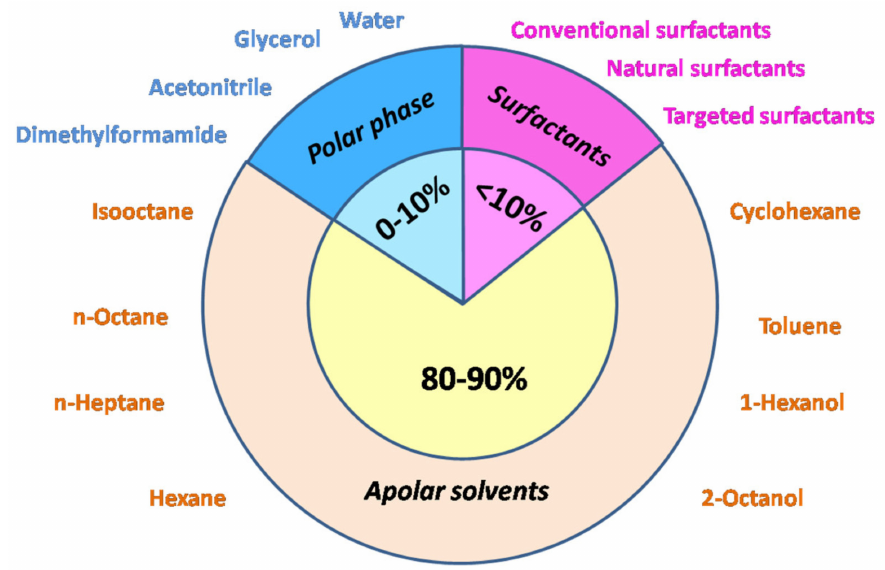
Figure 3. Relative proportion of components in a reverse micellar (RM)